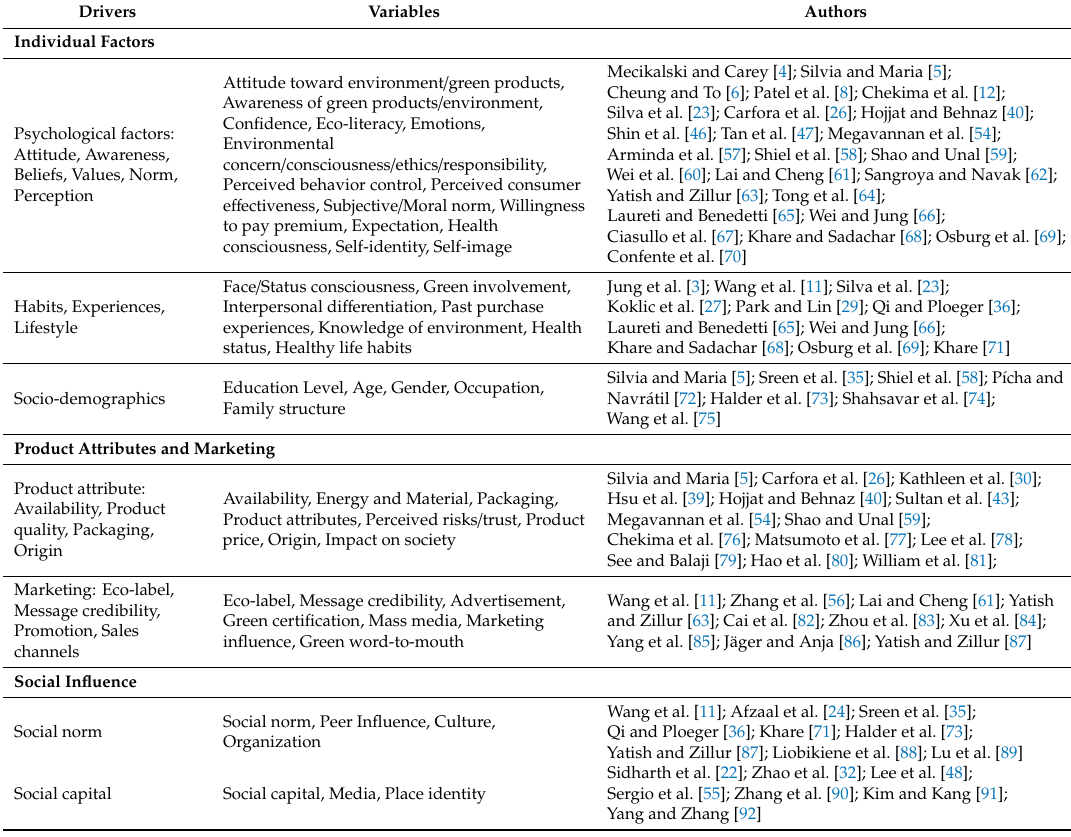
Table 3. Key factors influencing green purchase